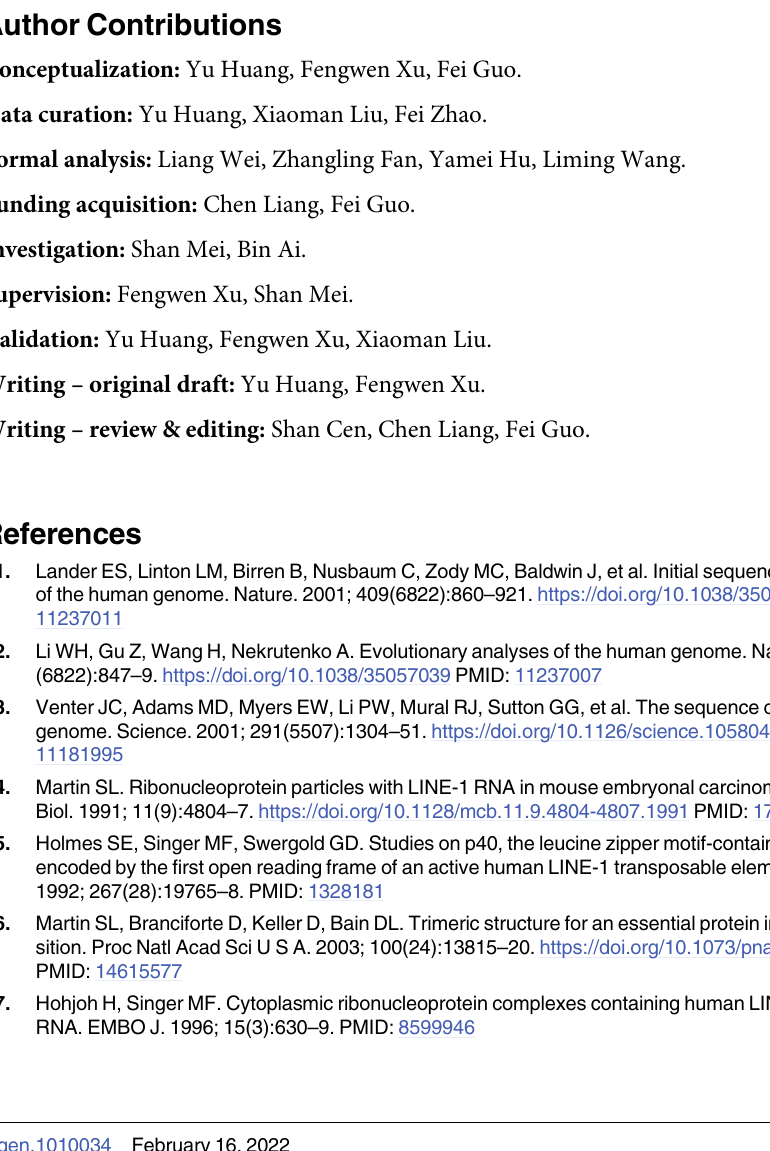
Content Screen system (PerkinElmer) was utilized to determine the ratios of the nuclear and cytoplasmic ORF1p. The results are summarized in the bar graph (mean ± SEM; paired t -test). ns, not significant. �� , P < 0.01; ��� , P < 0.001. S10 Fig. Phylogenetic analysis of of Mx genes from different species. Neighbor-Joining method was used for the evolution analysis. Orthologous Mx2 sequences were acquired from Genbank. The protein sequences were aligned using Clustal Omega and converted to a codon alignment using MEGA 7. The Neighbor-Joining tree was calculated in MEGA 7 with 1,000 bootstrap replicates. Bootstrap values ( > 70) were also tested. Mx genes were selected from MxA-like and MxB-like major clades. “ � ” indicates the Mx genes that were investigated in this study for inhibiting LINE-1 retrotransposition. S1 Table. Primers and RNAs used in this